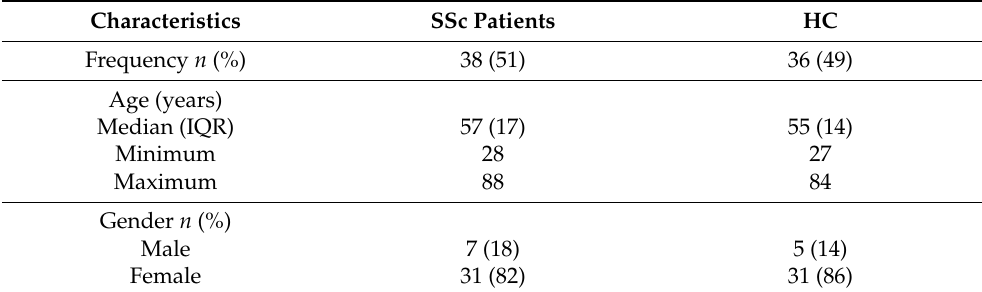
Table 1. The demographics of the SSc patients and the healthy controls.